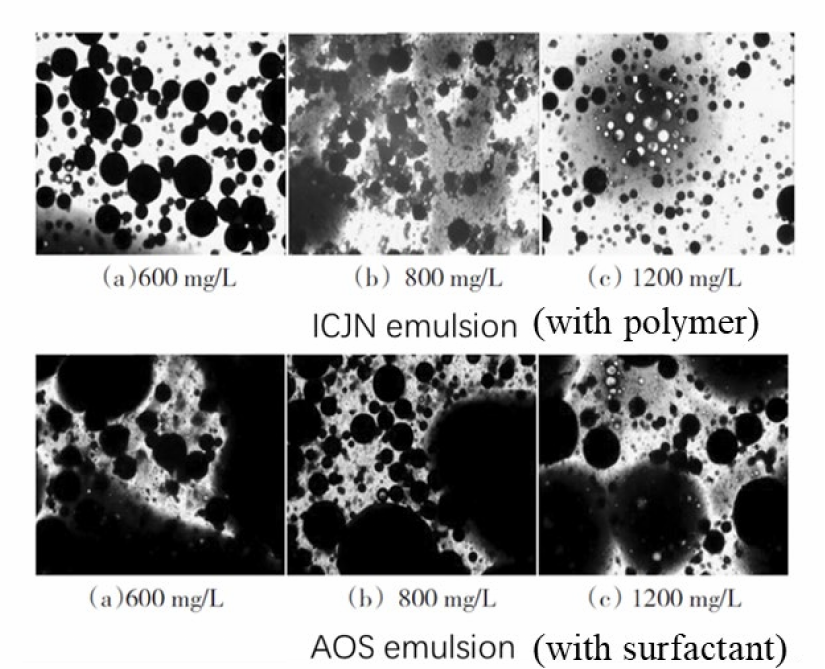
Figure 10. Comparison of emulsification abilities of amphiphilic polymers IAJN and AOS (revised after